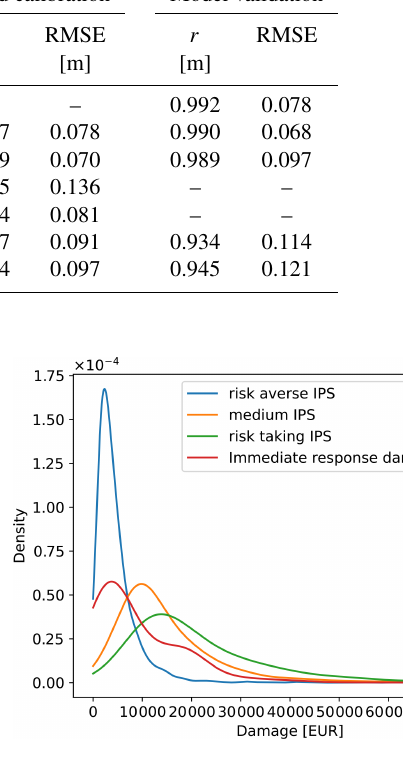
Figure 7. Kernel density plot: damage estimates and claims. Table 9. Performance indicators of damage estimates based on hy- structures with immediate response